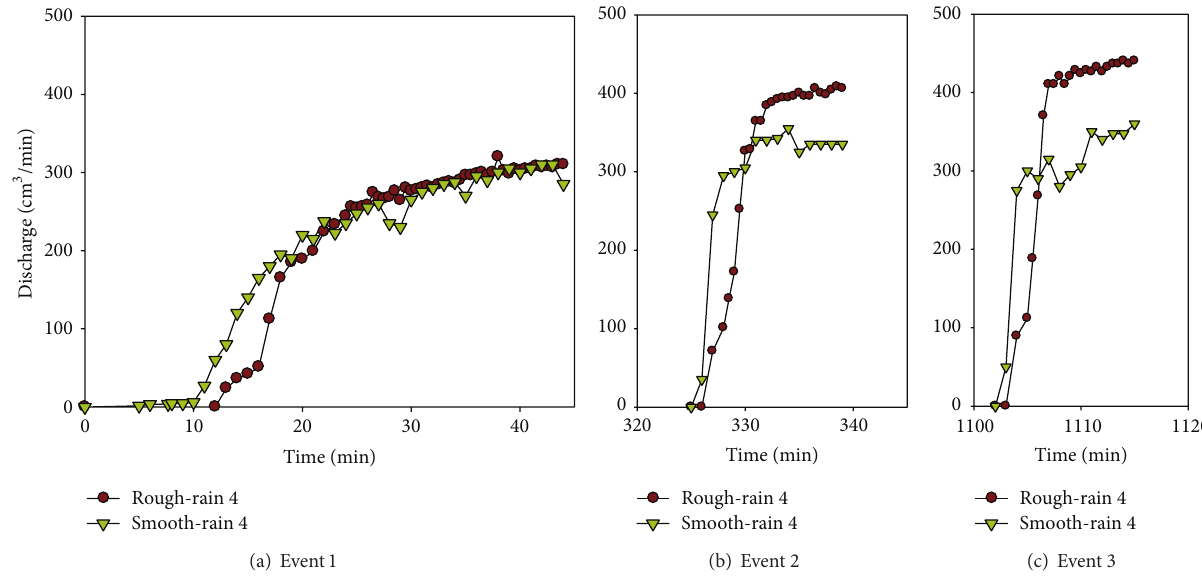
Figure 6: Observed hydrographs of the laboratory rough and smooth surfaces for a complex rainfall pattern that consists of three stages of rainfall alternating between wet and dry time periods (Rain 4: 5.95-0-5.95-0-5.95